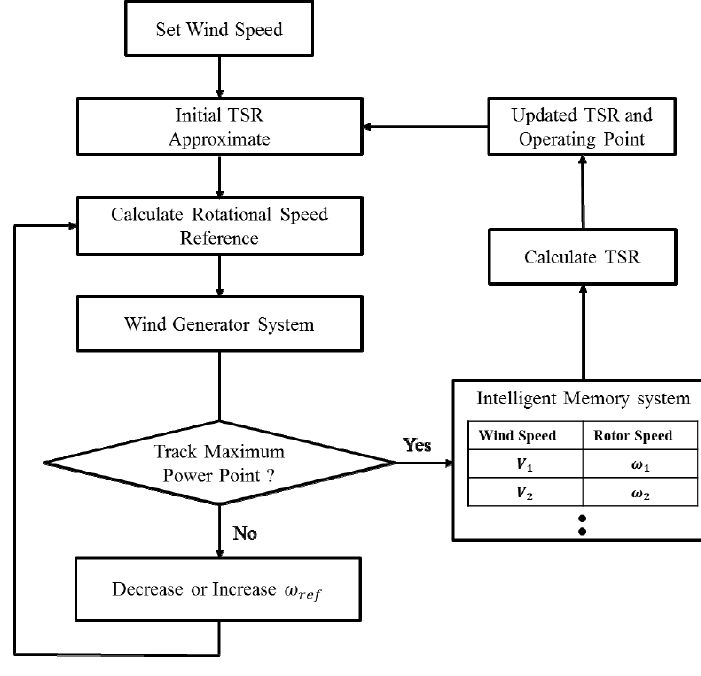
Figure 5. Improved hill climb searching (IHCS)